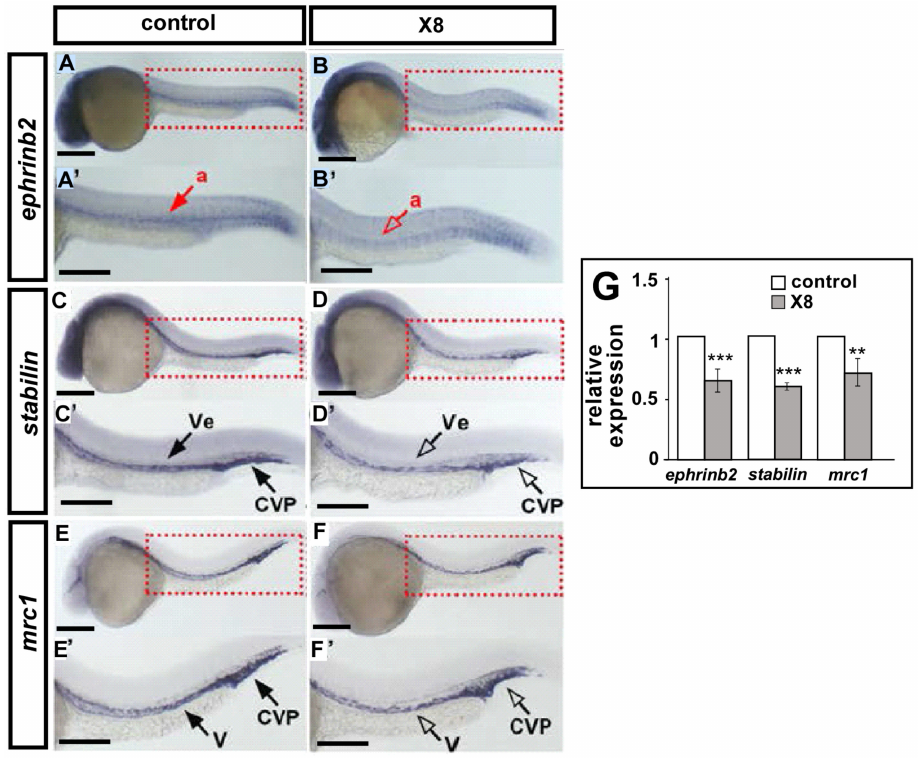
Figure 5. X8 treatment of embryos decreases the expression of vascular markers. ( A – F , A’ – F’ ) Com- pared with wild-type control embryos ( A , C , E ), X8-treated embryos exhibited decreased expression of the arterial (a) marker ephrinb2 ( B ), the panvascular (v) marker stabilin ( C ), and the venous (ve) marker mrc1 ( E ) in the trunk vessels and CVP at 24 hpf. ( G ) Quantification of the relative expression level by qPCR showed reductions of approximately 30–40% in the expression of the vascular markers ephrinb2 (0.6 ± 0.15), stabilin (0.6 ± 0.1), and mrc1 (0.7 ± 0.16) in X8-treated embryos. *** p < 0.0001 and ** p < 0.001 by unpaired Student’s t -test. The data are presented as the mean ± SD values. Scale bars: 200 µ m in ( A – H